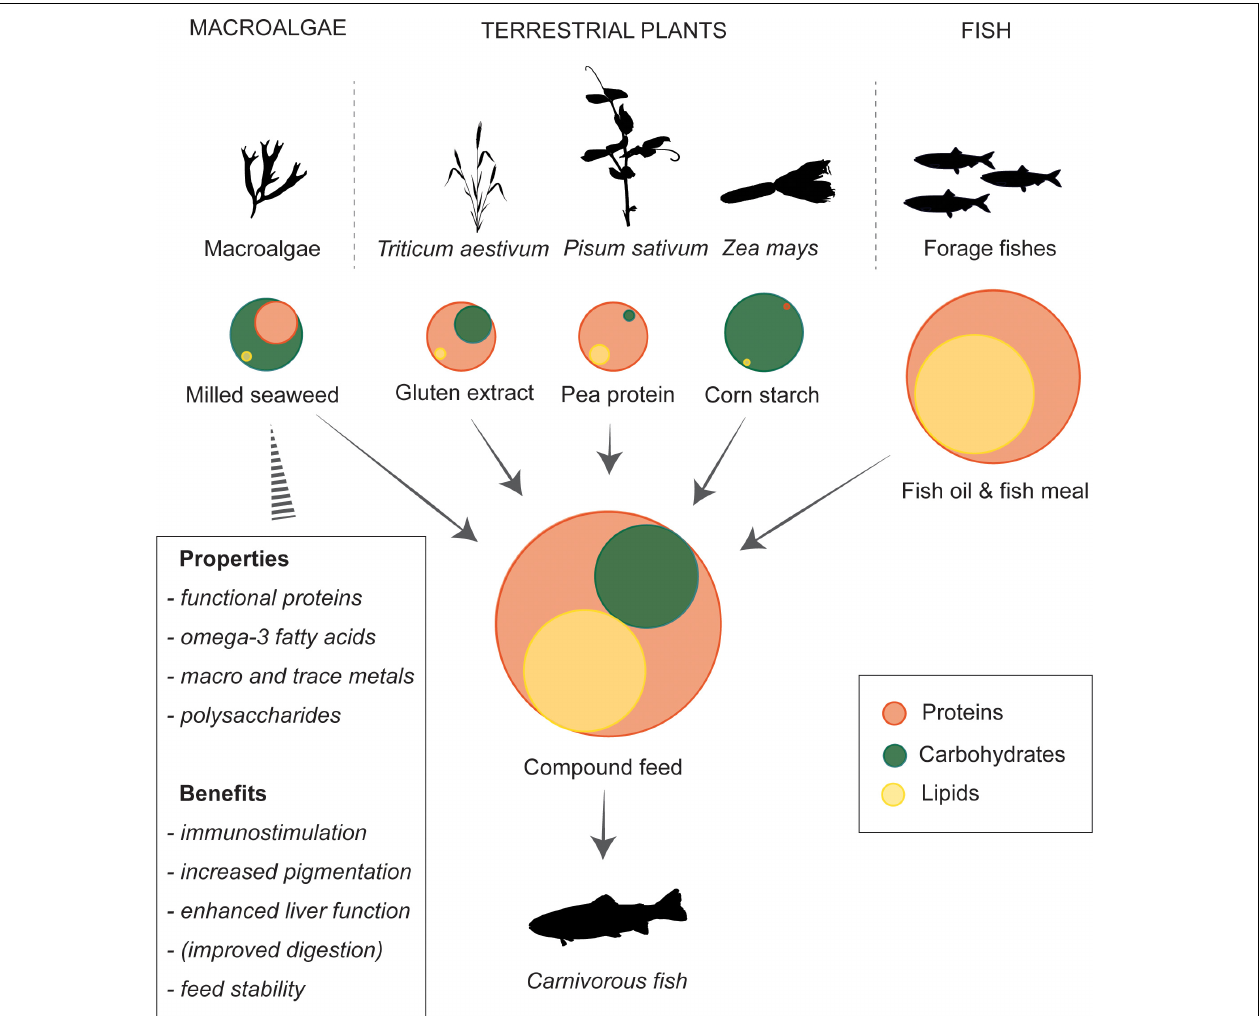
FIGURE 1 | Schematic presentation of seaweed inclusion in compound feeds containing plant and fish derived ingredients for a carnivorous fish. The filled circles represent the relative proportion of macronutrients in each ingredient in the P10 experimental diet by Wan et al. (2016), the arrows pointing to the compound feed denote its ingredients, the arrow to the carnivorous fish indicates it feeds on the compound diet, and the striped triangle links to the box outlining key properties and benefits of milled seaweed ingredients in aquafeed. Silhouettes from PhyloPic (http://phylopic.org) under Creative Commons